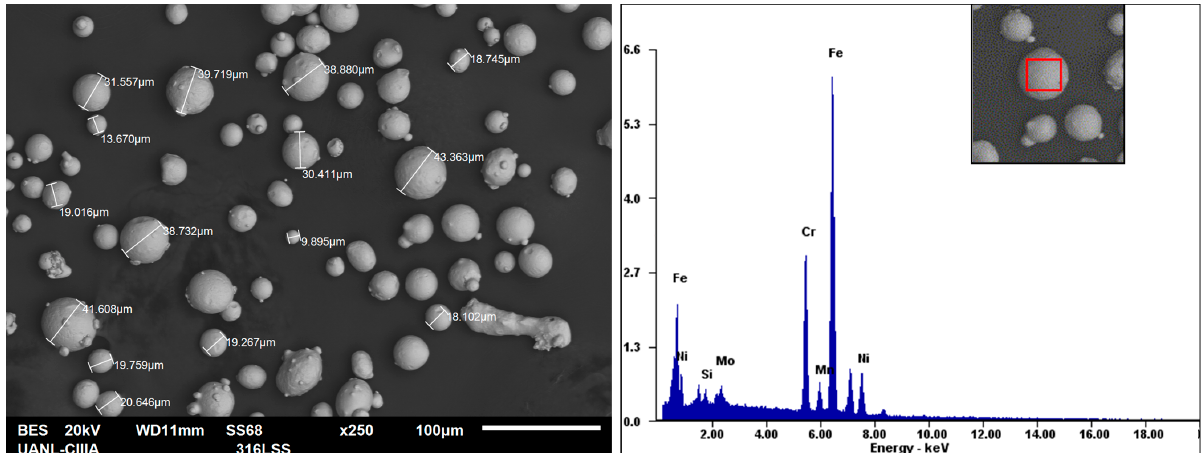
Figure 1. SEM image of the 316L stainless-steel metal powder obtained in this study showing the size of some particles ( left side ) and EDS analysis in one of those particles ( right side ). Table 1. Chemical composition (in wt.% ) of the 316L SS powder and the SLM-prepared sample. Table 2. SLM processing parameters used to manufacture the 316L SS